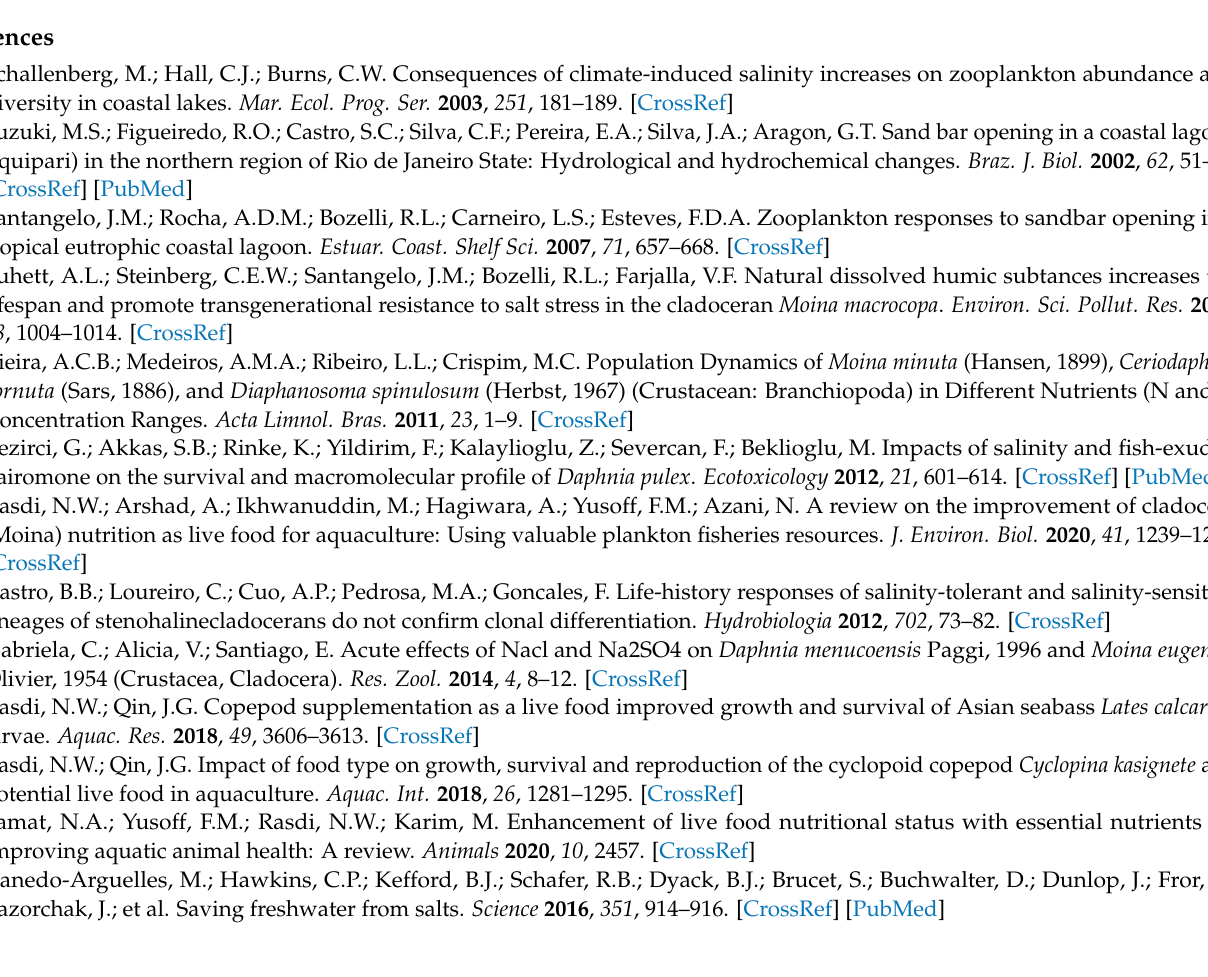
Table S2: The ANOVA results on the growth of M. macrocopa in responds to different salinity, Table S3: The survival of M. macrocopa in responds to different salinity, Table S4: Population density data of M. macrocopa, Table S5: The mean, standard deviation, sum of squares data on the effect of salinity on survival and reproductive capacity of M. macrocopa in response to different salinity; Table S6: The ANOVA data on fatty acid effects in response to different